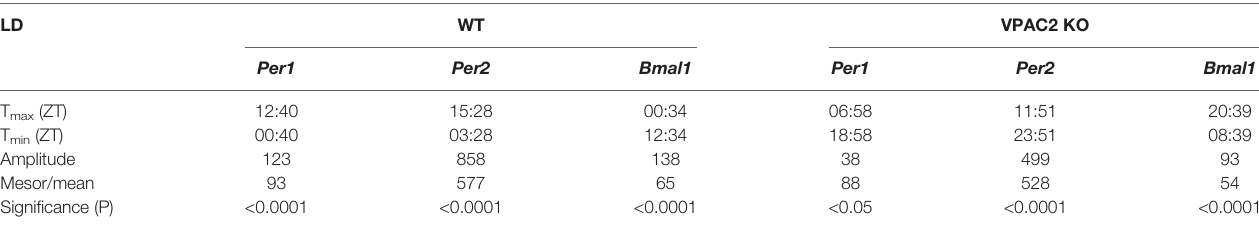
TABLE 1 | Parameters of 24-h rhythmometric analysis of Per1, Per2 and Bmal1 mRNA expression in thyroid glands of wildtype (WT) and VPAC2 receptor knockout mice (VPAC2 KO) during light-darkness. LD WT